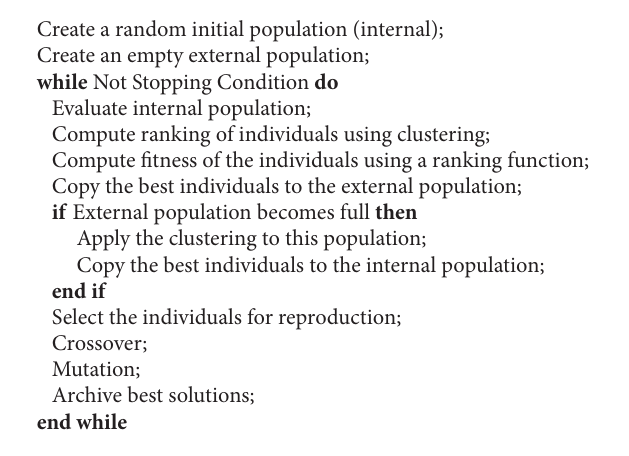
Algorithm 1: Reduced Pareto set genetic algorithm